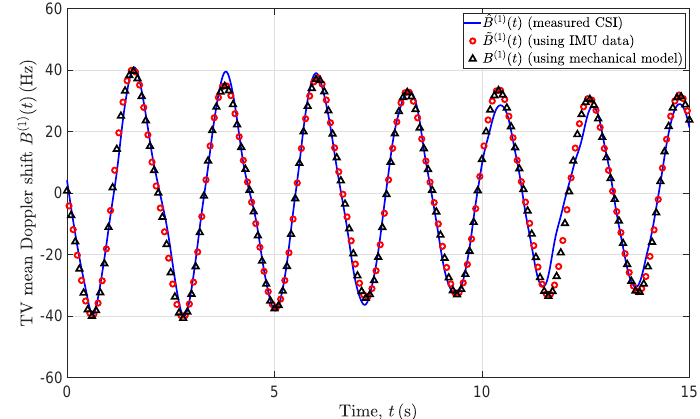
Figure 6. TV mean Doppler shifts ˜ B ( 1 ) ( t ) , B ( 1 ) ( t ) , and ˆ B ( 1 ) ( t ) computed from the spectrograms of the channel model with IMU data as inputs, mechanical model as inputs, and the measured CSI,